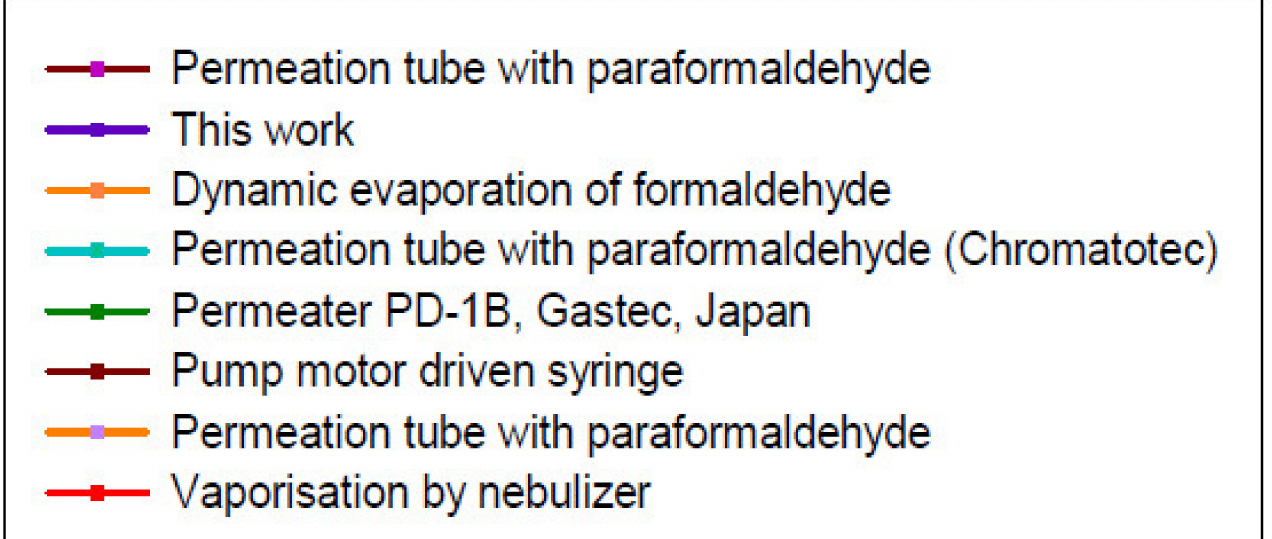
Figure 12. Comparison of gaseous formaldehyde concentrations generated vs. gas flow rate us- ing the different dynamic generation methods reported in the literature and this work. A: per- meation tube with paraformaldehyde, Andrawes et al, (1984) [54]; B: pump motor driven sy- ringe, Andrawes et al, (1984) [54]; C: vaporization with nebulizer of aqueous formaldehyde solu- tion, Lindahl et al, (1996) [56]; D: permeation tube with paraformaldehyde, Aoyagi et al, (2012) [59]; E: Dynamic evaporation of aqueous formaldehyde solution, Zhu et al, (2019) [60]; F: Commercial instrument, Permeation tube with an aqueous solution of formaldehyde, Permeater PD1-B, Gastec, Japan [77]; G: Commercial instrument, permeation tube with paraformaldehyde, Chromatotec [76]; H: This